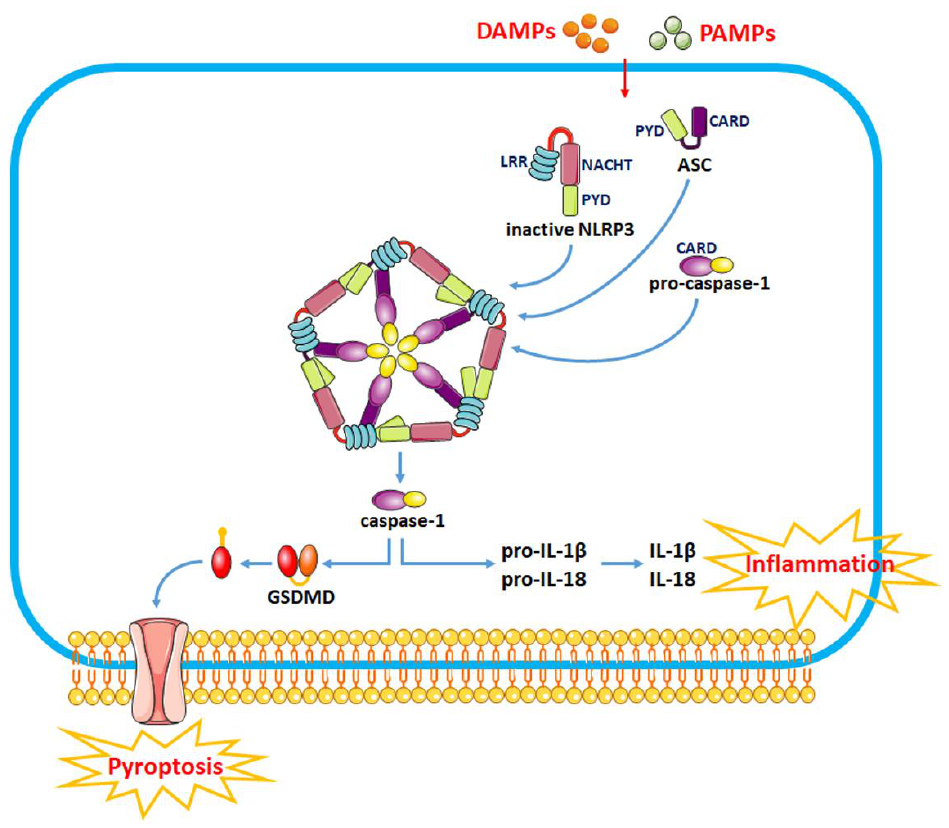
Figure 1. The recognition of DAMPs and PAMPs induces a change in the NLRP3 protein structure and the exposure of its PYD domain to bind to the PYD of ASC, thus forming a PYD–PYD interaction. Then, ASC recruits the cysteine protease pro-caspase-1 to assemble the inflammasome complex via interacting with CARD. Pro-caspase-1 is activated by self-cleavage to form active caspase-1. Ac- tivated caspase-1 dissociates GSDMD and releases its N-terminal domain, which interacts with the cell membrane to produce pores and induce “pyroptosis”. In addition, caspase -1 can also induce the transformation of IL- 1β and IL -18 precursors into mature IL- 1β and IL -18 to induce inflamma- tory responses.